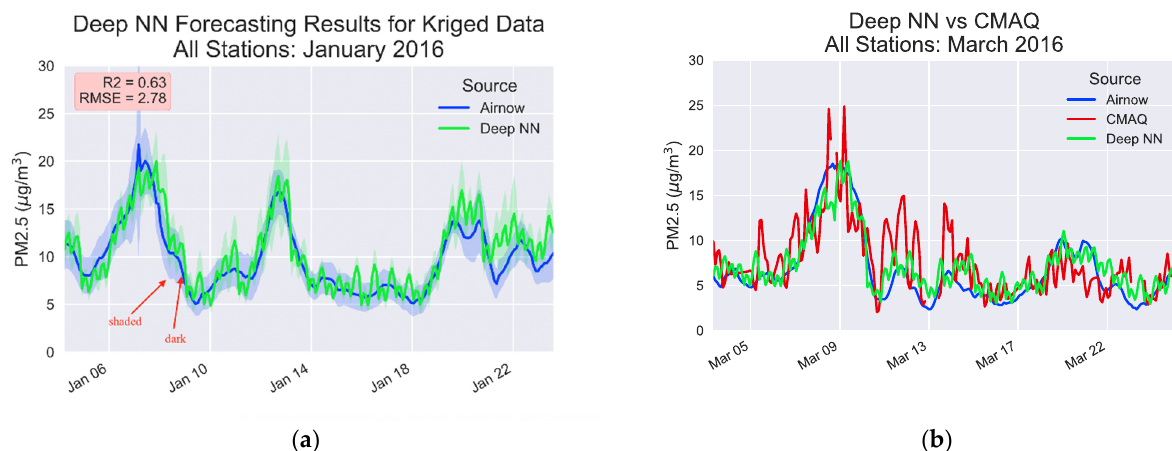
Figure 9. Time series plot for the DNN forecaster: ( a ) DNN compared to NYSDEC ground monitoring stations, including resultant mean deviation of all stations due to cross-validation, January 2016; ( b ) inclusion of the Community Multi-Scale Air Quality system (CMAQ) forecasts (averaged over all stations) for March 2016.